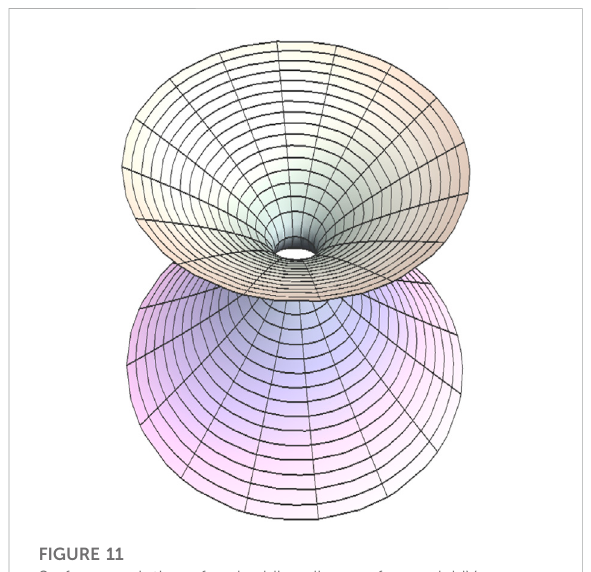
FIGURE 11 Surface revolution of embedding diagram for model IV.